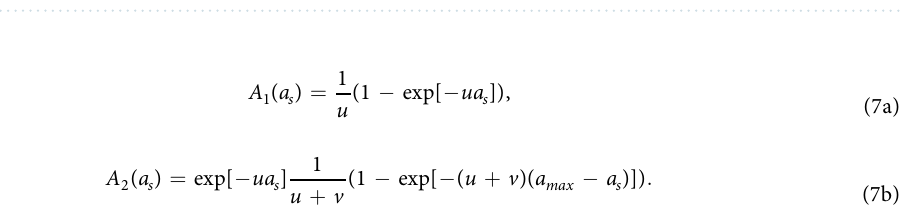
β β = = . 1 0 ). ( b ) The optimal size for foraging is larger than 1 2 1 2 , β = . 2 0 ). The parameters in ( b ) are as follows: α = . 1 0 1 2 , β = . 5 0 ). The parameters in ( c ) are as follows: α = . 1 0 1 2 = . a 5 0 , = . u 0 1 , and = R 10 max